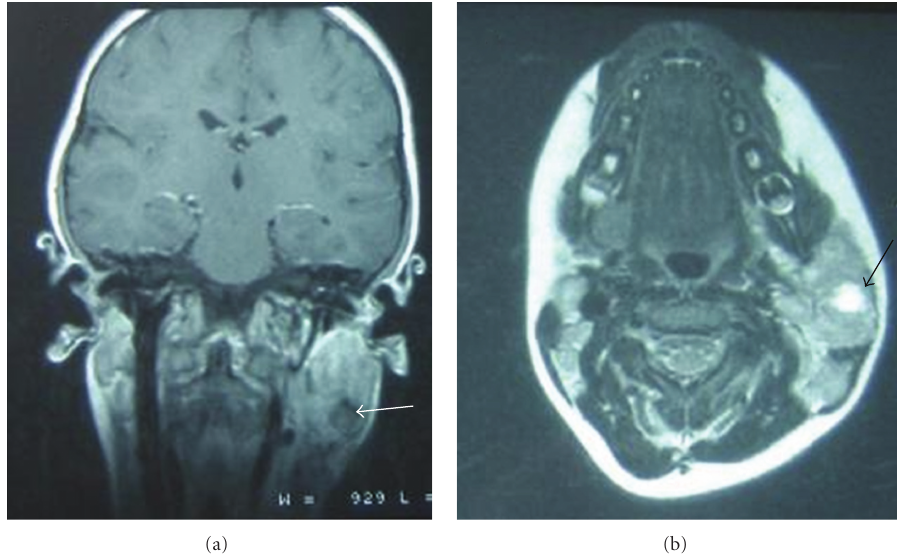
Figure 1: Coronal T1-weighted (a) and axial T2-weighted (b) cervical magnetic resonance imaging showing a parotid gland tumor with a heterogeneous signals with a central area of necrosis (arrow).